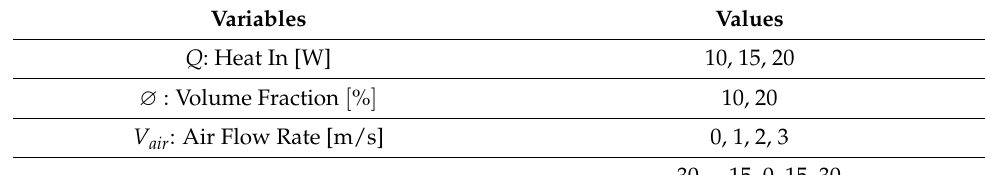
Table 5. Variables of the experiment.